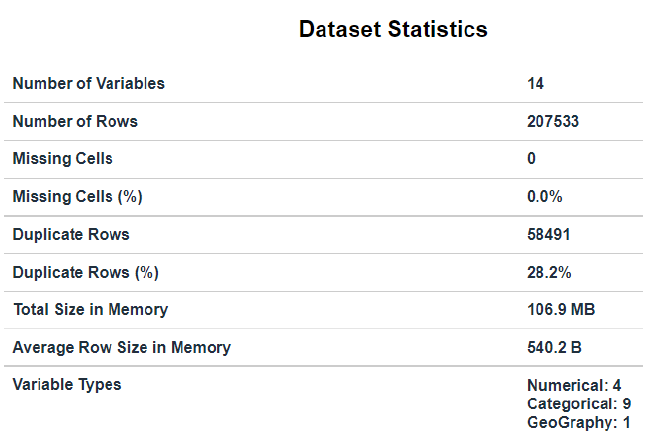
Figure 8. The UGRansome data summary.